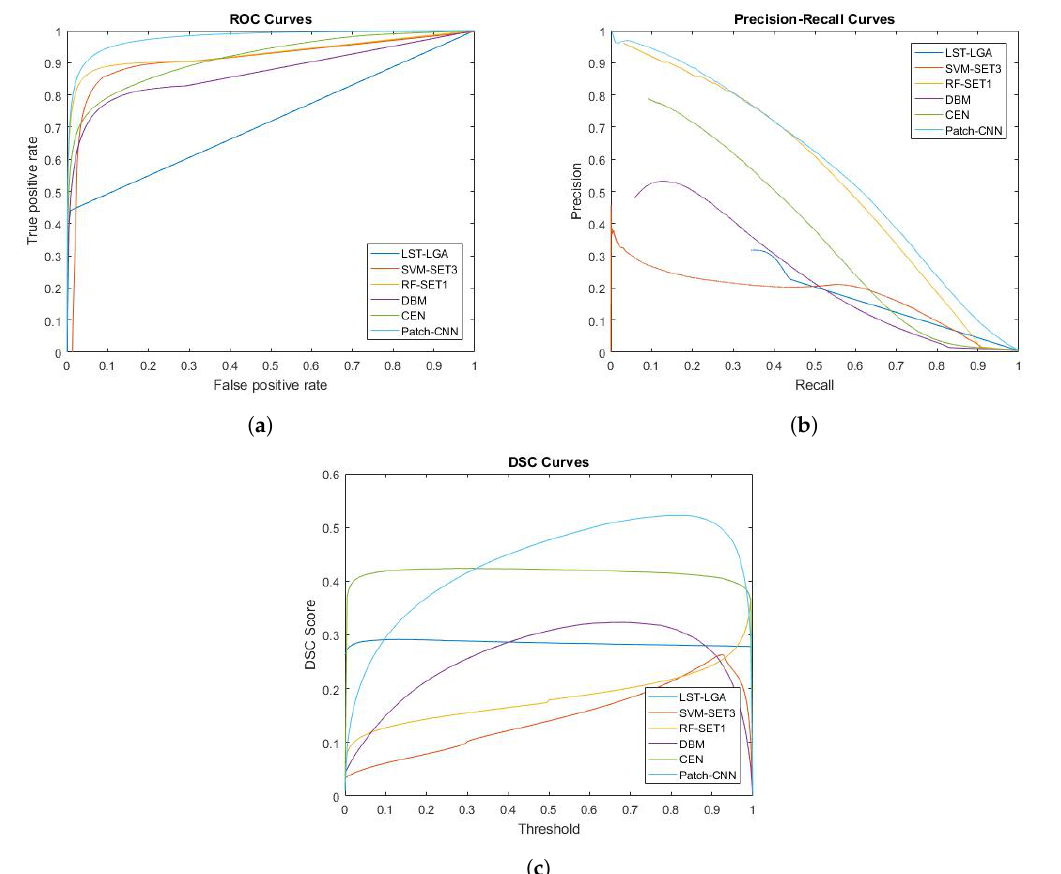
Figure 7. Performance curves of ROC, PR and DSC for LST-LGA, SVM-SET3, RF-SET1, DBM, CEN and patch-CNN. SVM-SET3 and RF-SET1 represent conventional machine learning algorithm chosen from previous experiment while DBM, CEN and patch-CNN represent deep learning algorithm. On the other hand, LGA is unsupervised learning algorithm from LST toolbox. ( a ) ROC curve; ( b ) Precision-recall curve; ( c ) DSC